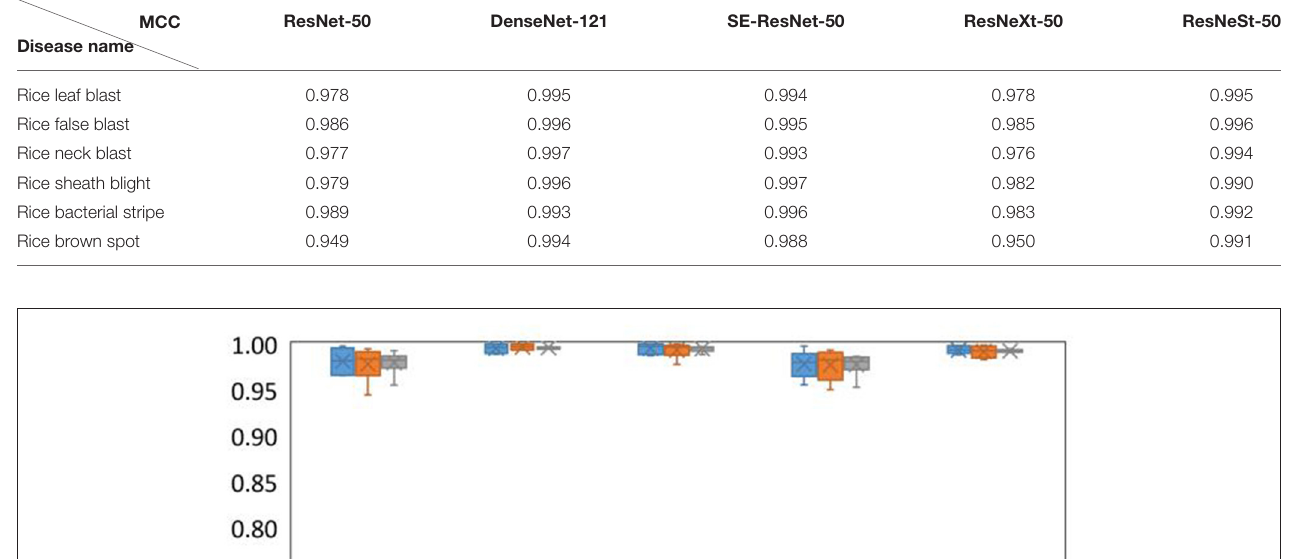
CAM without changing the structure of model. Grad CAM is an improved version of Grad CAM, which introduces the weighting of the output gradient for the pixel level at a particular location, and it has better effects than Grad